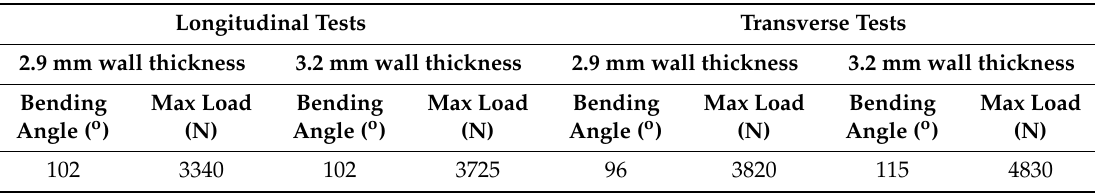
Table 3. Results of bending tests (three tests in every category). Tests were interrupted at 10% load